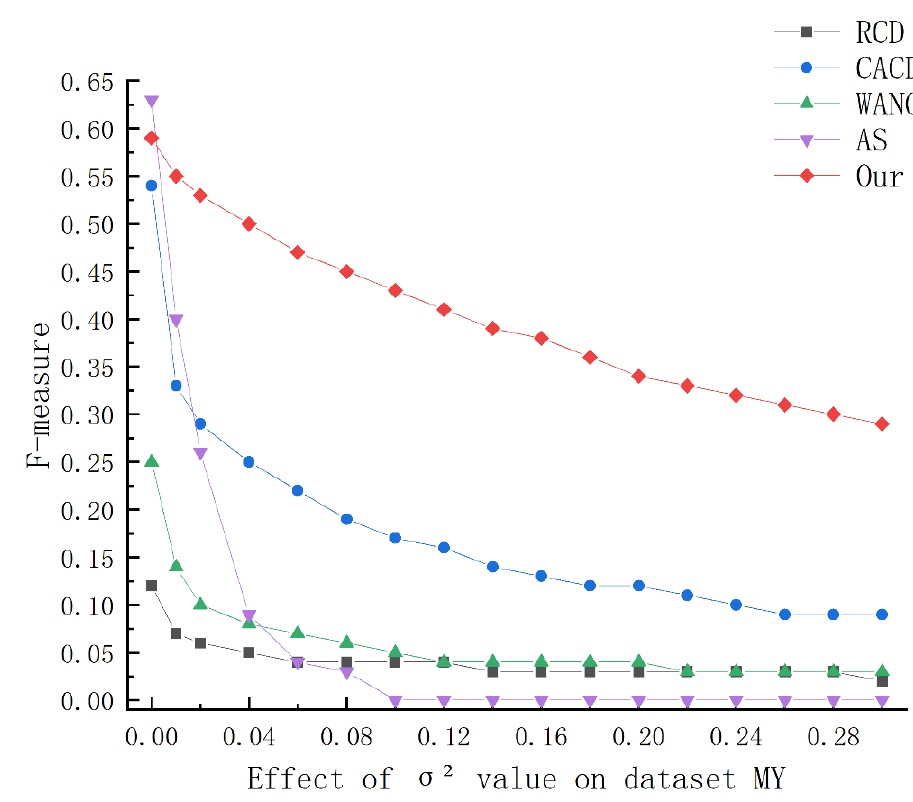
Figure 7. Variation of F-measure on dataset